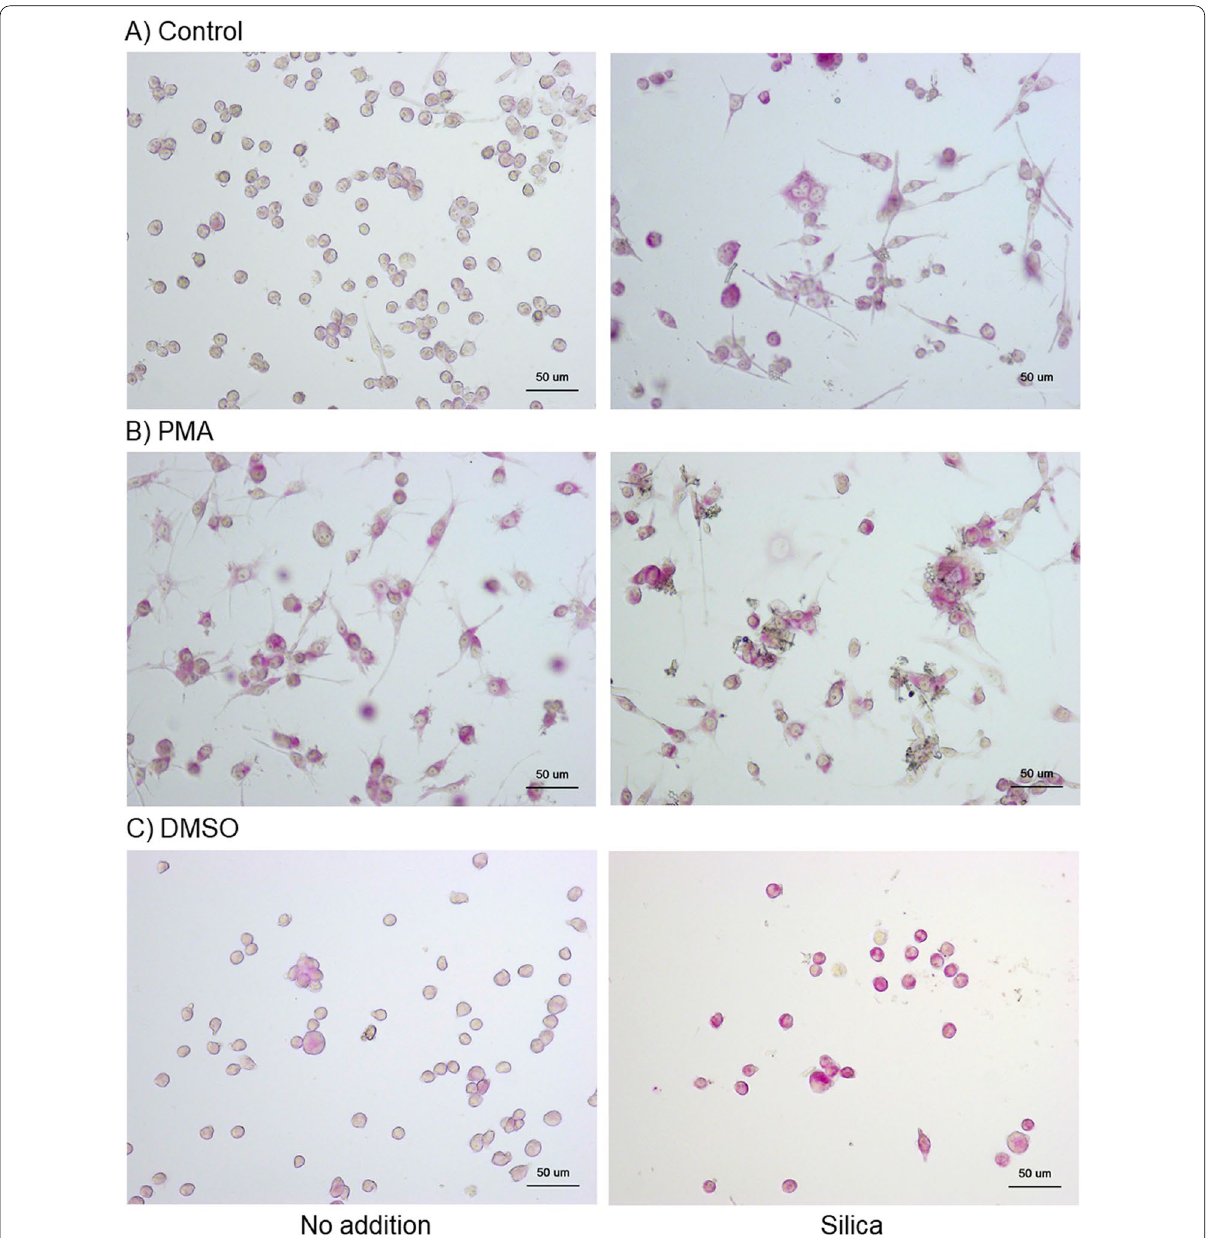
Fig. 4 Effects of silica microparticles (MPs) on acid phosphatase (ACP) activity in control A and phorbol 12-myristate 13-acetate (PMA)- B and dimethyl sulfoxide (DMSO)-treated HL60 cells ( C ). These cells were simultaneously treated with silica MPs for 3 days. The cells were then fixed and subjected to cytochemical ACP staining. Similar data were obtained from two additional independent experiments ( n